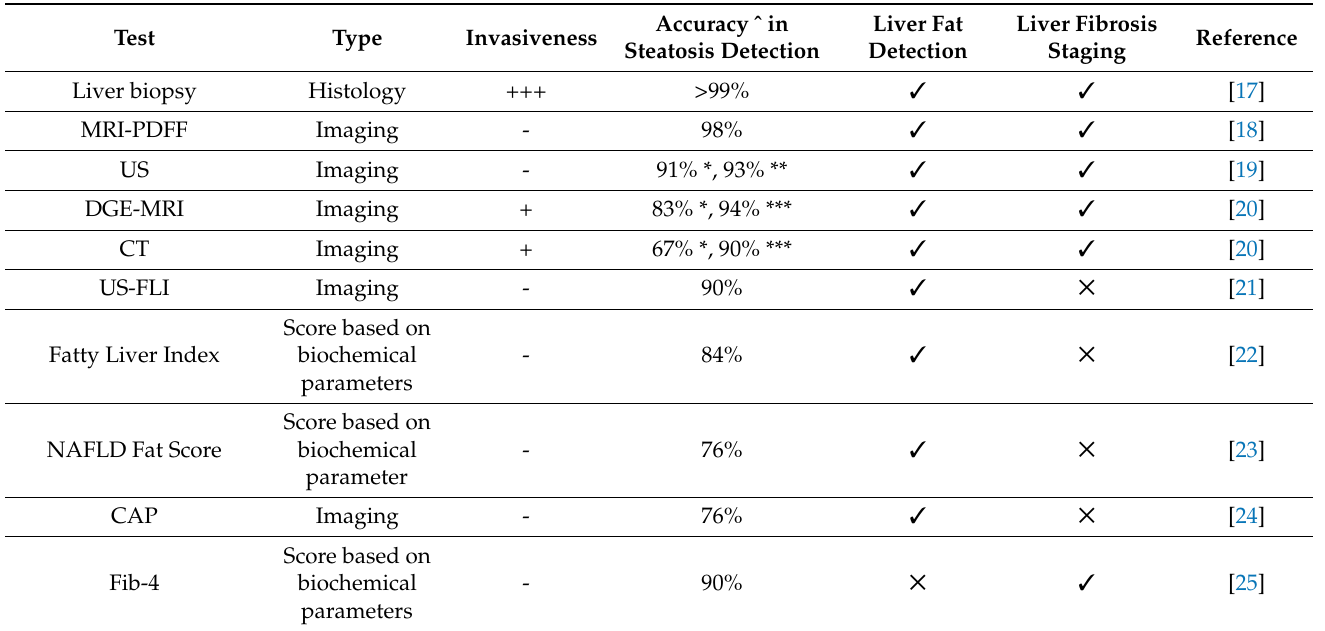
Table 1. Current strategies to diagnose and stage